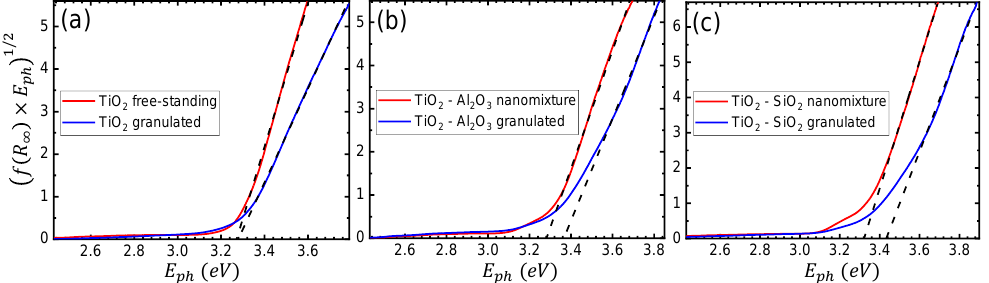
Figure 5. Tauc plots of the diffuse reflectance spectrum with linear fits (black dashed lines) for ( a ) TiO 2 , ( b ) TiO 2 - Al 2 O 3 , and ( c ) TiO 2 - SiO 2 nanoparticles of both free-standing (nanomixture) and granulated nature. The intersection point of each linear fit with the horizontal axis corresponds to the extracted energy band gap E g